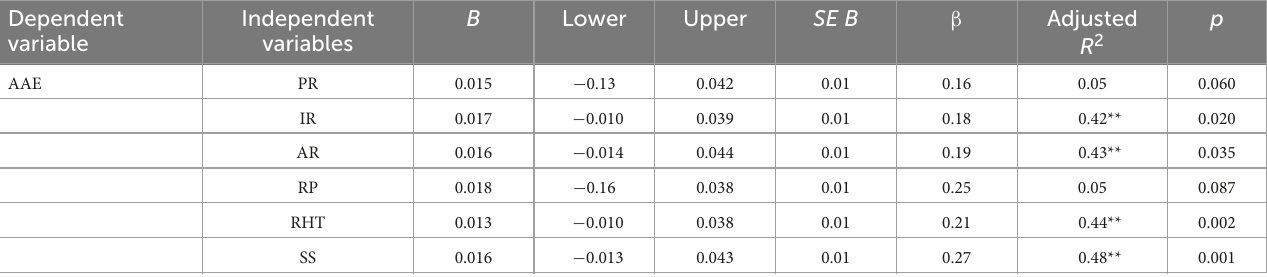
TABLE 3 Summary of regression analyses, with 95% confidence intervals, of students’ reading habits and study skills predicting academic achievement in English. Dependent